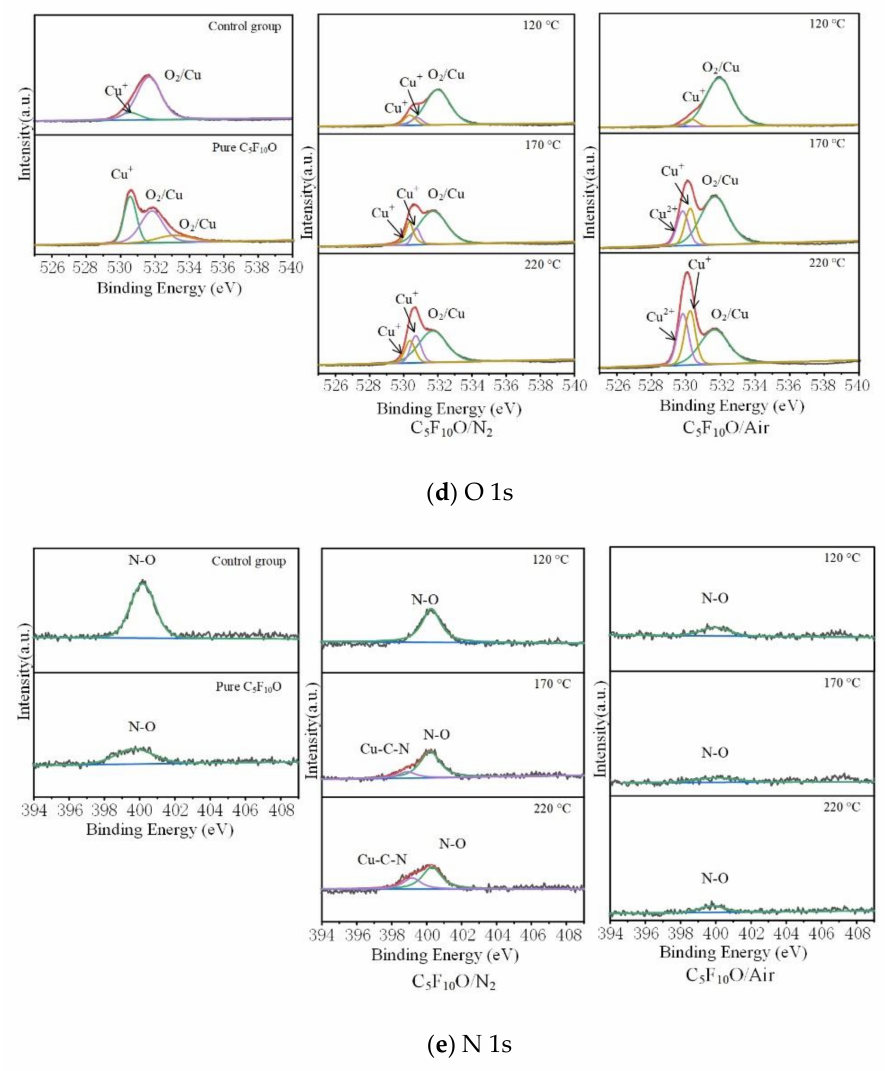
Figure 7. Copper surface element XPS energy